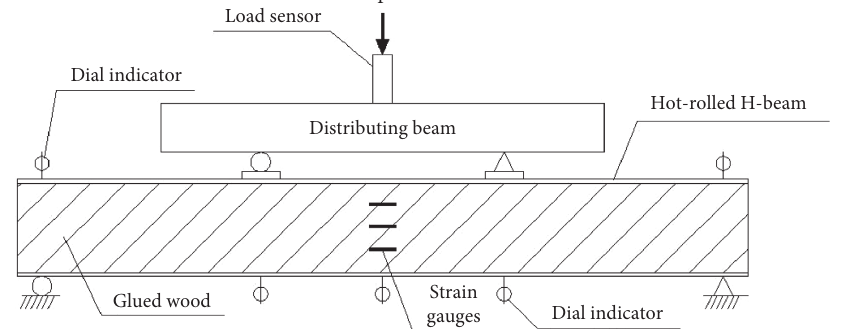
Figure 4: Layout of measuring